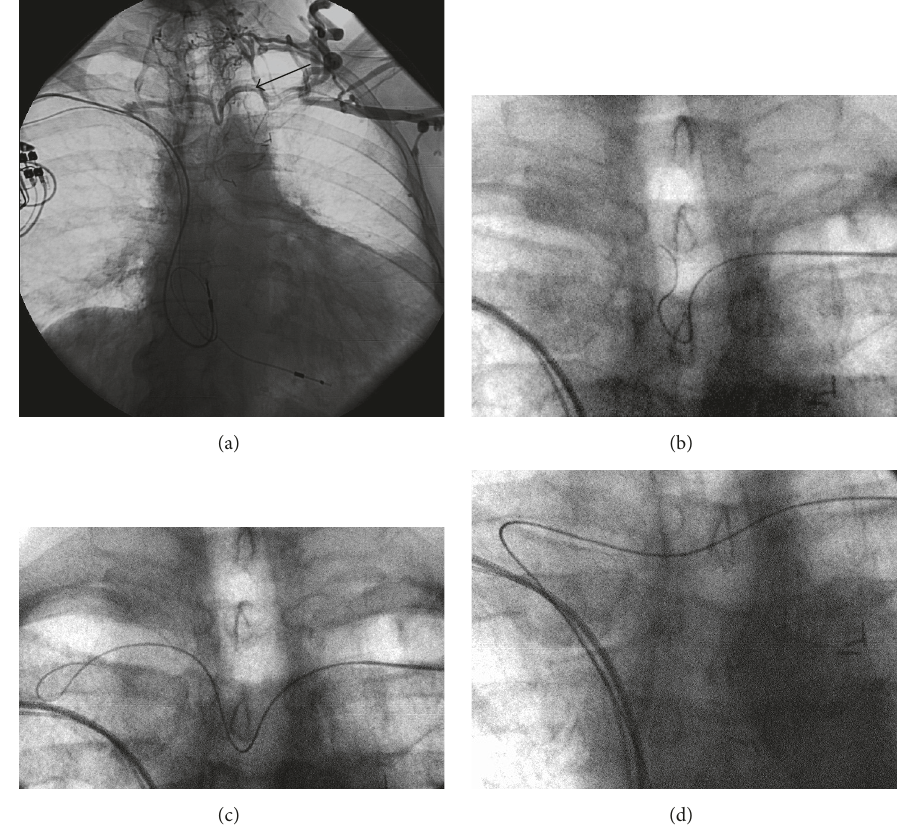
Figure2:PhlebographycorrelationoftheleftarmdemonstratesthesamecollateralcirculationasintheCT,fullycomparabletoFigure 1(a)(a). Note arrow indicating the exact location of the following vascular access. (b–d) Fluoroscopy with last-image hold images showing a guidewire stepwise navigated through the AJVS crossover to the right side and from here through the right innominate vein along the pacemaker leads into the inferior vena